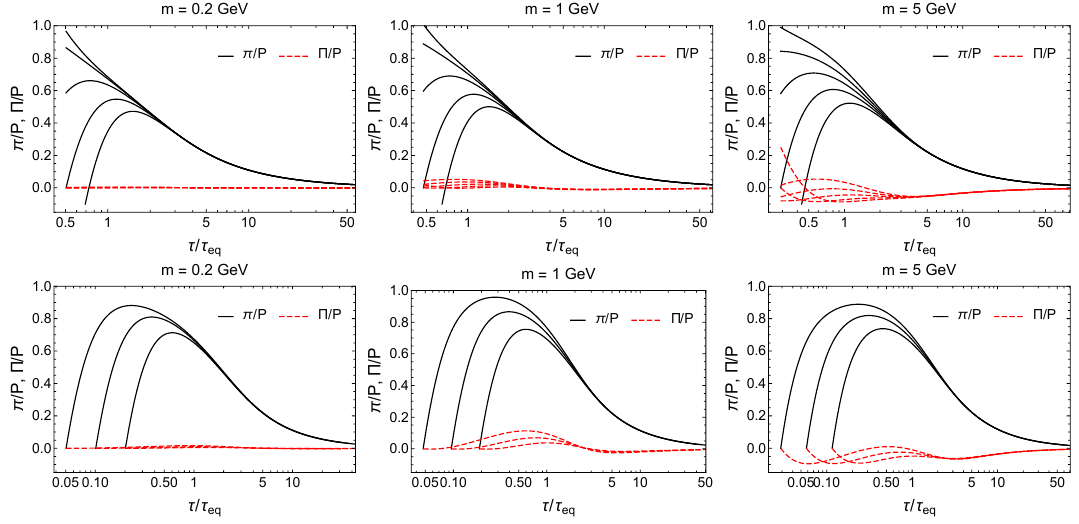
Figure 10 . Scaled shear and bulk viscous corrections from eqs. (2.35) and (2.33), respectively, as a function of rescaled time τ/τ eq . The black solid lines are the scaled shear correction. and the red dashed lines are the scaled bulk correction. The rows and columns are the same as in figure